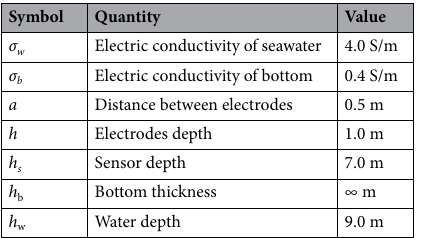
Table 2. Parameters of the analytical model in comparison analysis—Case I.